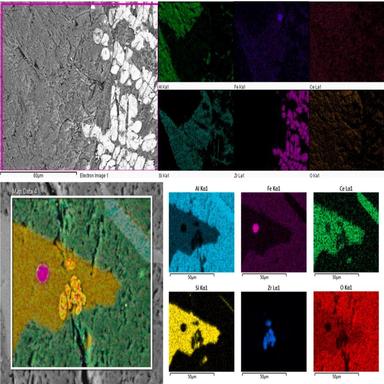
The qualitative analysis using SEM-EDS of the Bottom Surface layer of the stratified melt pool.